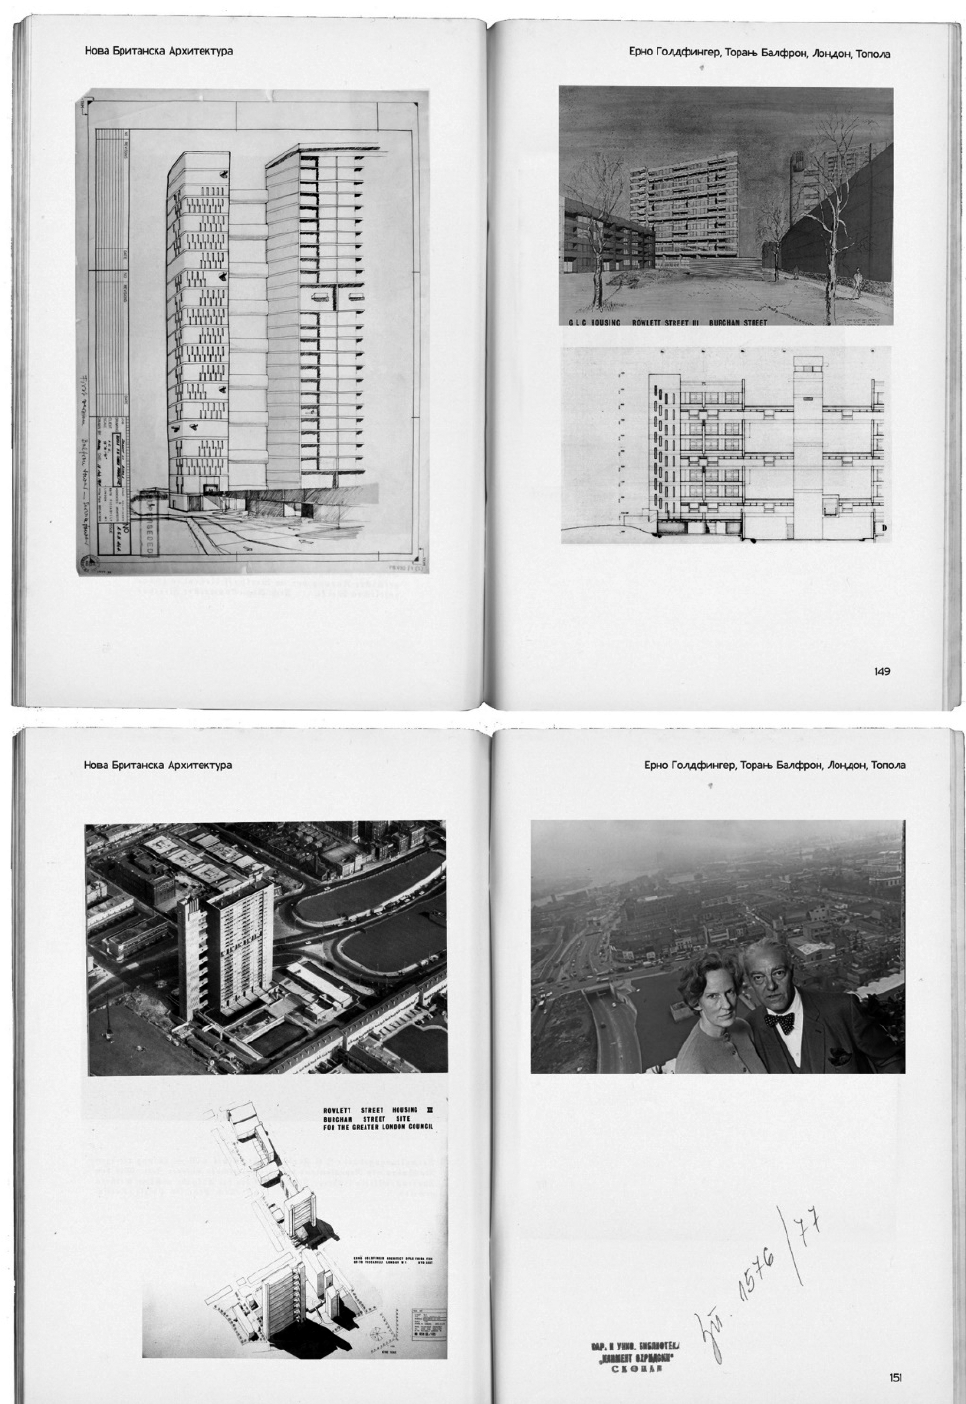
Figure 5. Georgi P. (1979), Nova Britanska Arhitektura , Architektonska Edizia,